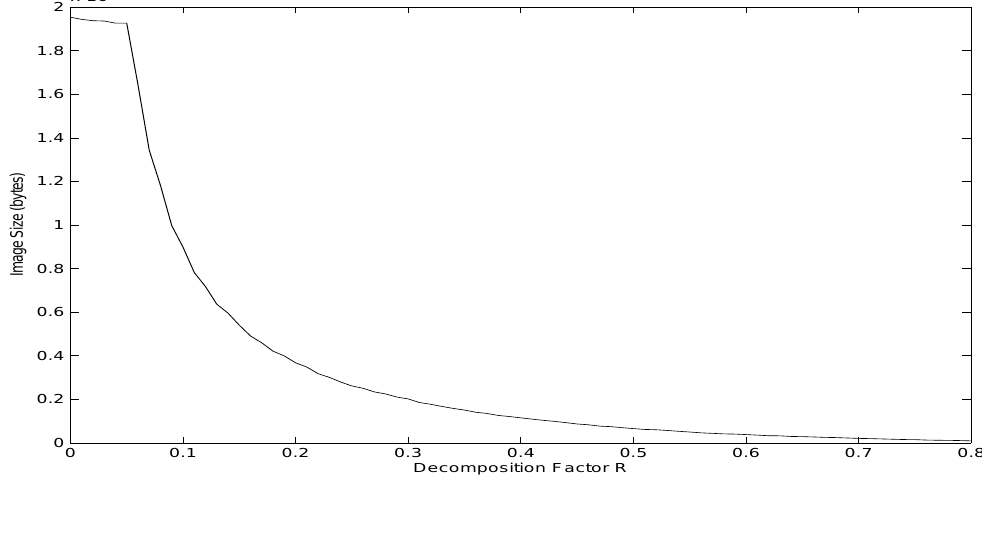
Figure 5 . Effect of the decomposition factor R on the QTD resulting image